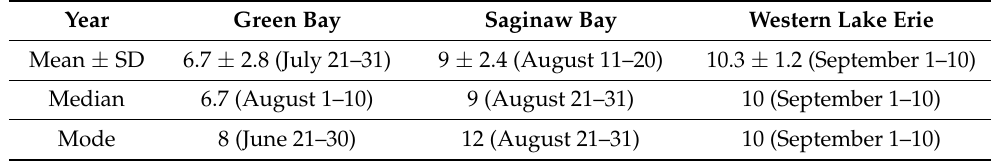
Table 2. The 10-day composite periods (dates in parentheses) exhibiting the highest mean, median, and mode integrated CI cyano values during the 10-year MERIS time series. Details on how values were calculated are given in Section